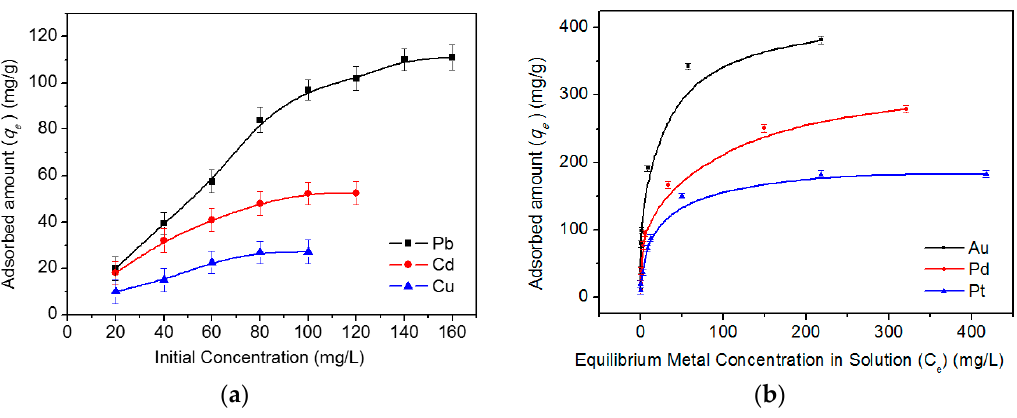
Figure 4. Adsorption isotherms of Cu 2+ , Pb 2+ , and Cd 2+ onto DTC-g-PE-DA@GB@PU ( a ) and Pd 2+ , Pt 4+ , and Au 3+ onto PE-DA@GB@PU ( b ). Other conditions: solution pH = 6 for DTC-g-PE-DA@GB@PU, solution pH = 0 for PE-DA@GB@PU; volume, 20 mL; adsorbent dose, 20 mg; contact time: 30 min for